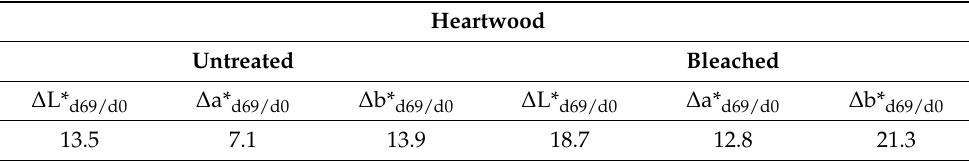
Table 5. Evolution of ∆ L*, ∆ a*, and ∆ b* values of untreated and bleached heartwood between the first (d0) and the last (d69) irradiation day.